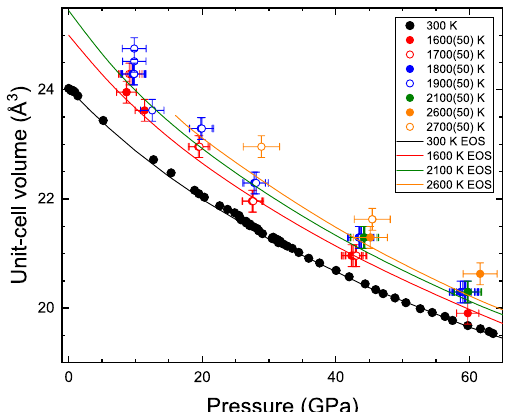
Figure 8. Unit-cell volume of Cr versus pressure for different temperatures. Different symbols correspond to different temperatures which are indicated in the figure. The solid lines are isotherms obtained from the P–V–T EoS determined in the present work. The 2600 K isotherm of bcc Cr is shown only for P > 16 GPa because at lower pressures Cr exists in the liquid